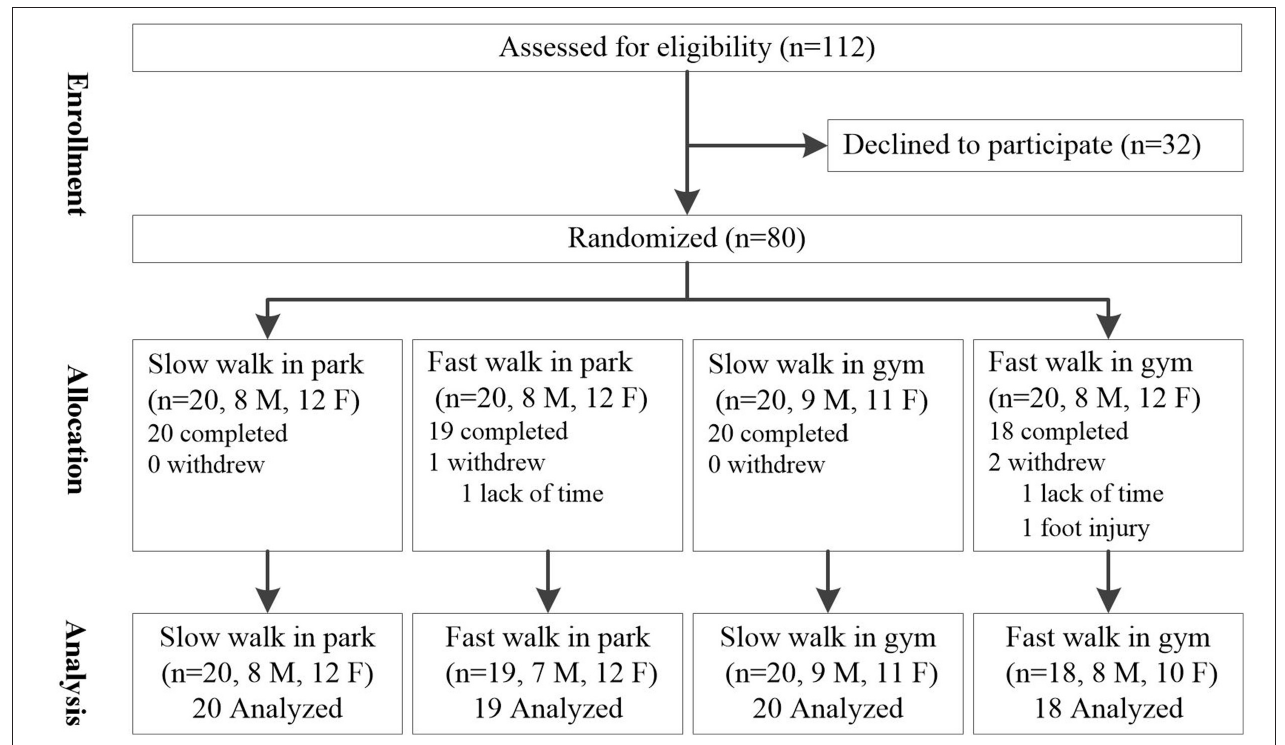
FIGURE 3 | Flow diagram of the progress through the phases of a parallel randomized trial.